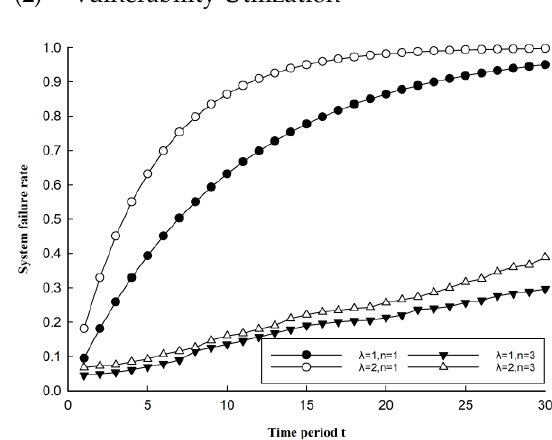
Figure 15. System failure